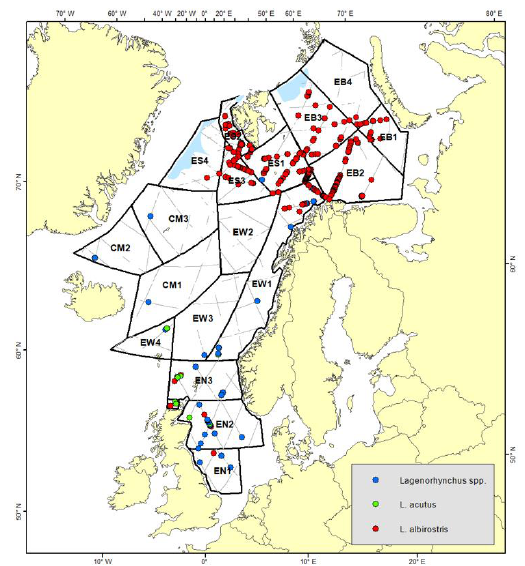
Figure 12. Distribution of sightings recorded as Lagenorhynchus spp. during the 2014 – 2018 sighting surveys. The blue areas represent ice